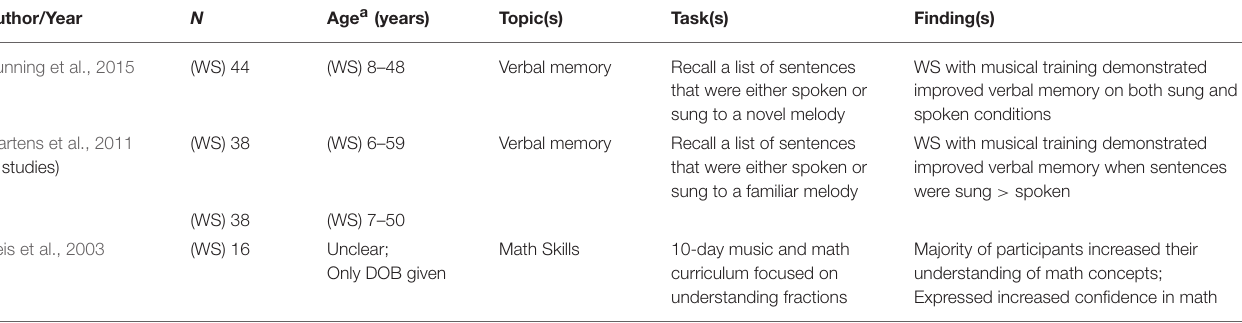
TABLE 7 | Cognitive processes: memory and